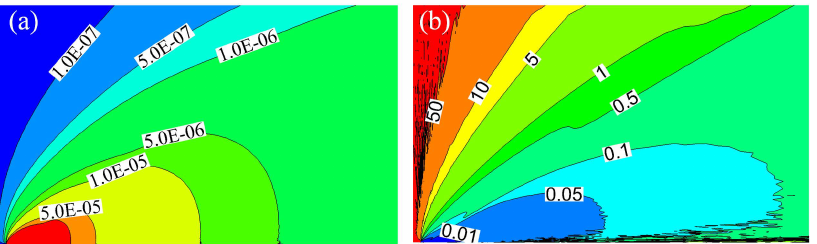
Figure 1. Simulation results of ( a ) density and ( b ) Knudsen number of a bipropellant thruster (6 N). The results are simulated via the software of plume work station (PWS), which is self-developed by Beihang University [1]. The unit of density is kg/m 3